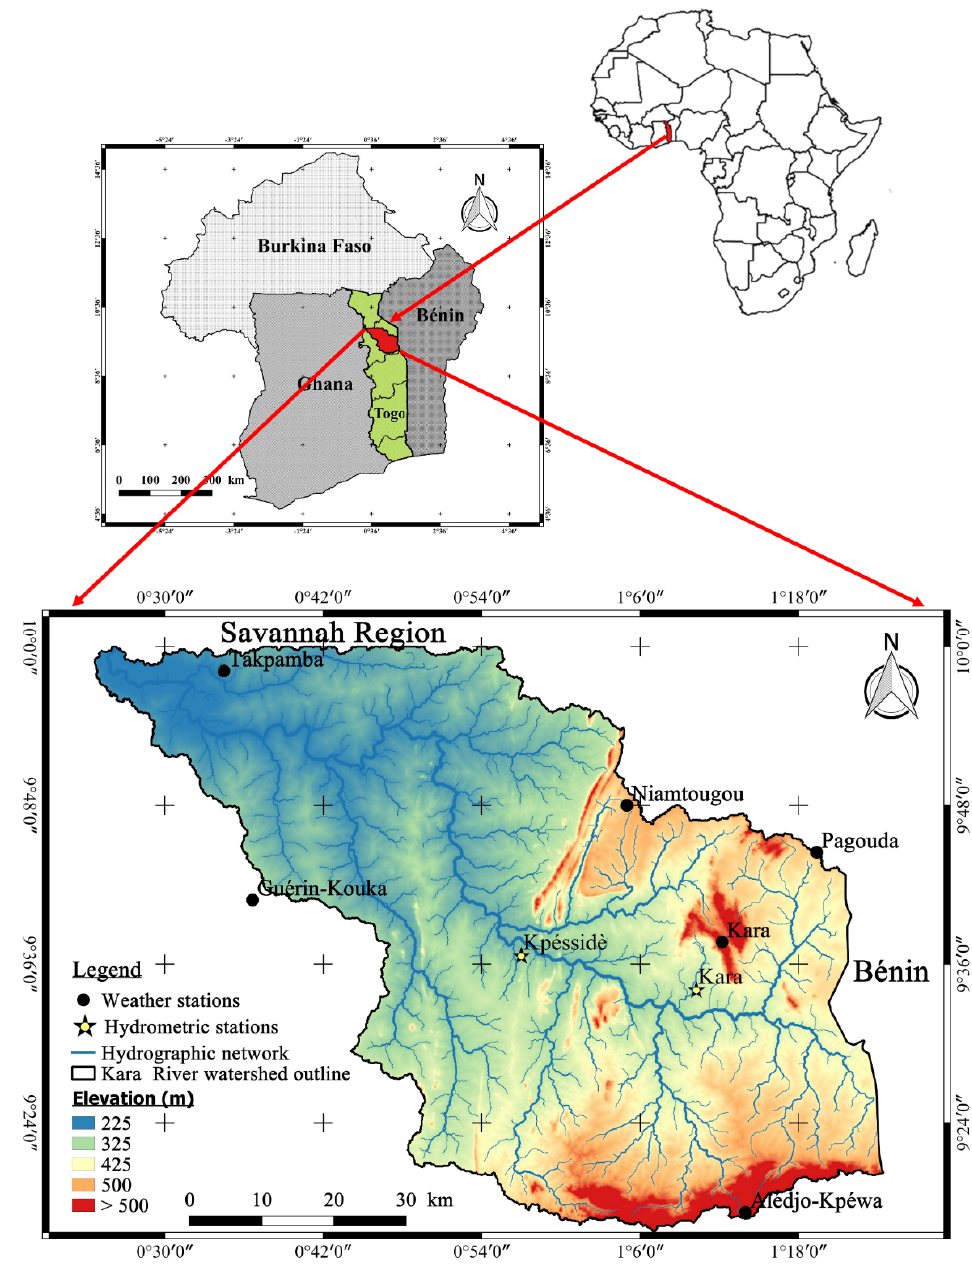
Figure 1. Geographical location, relief of the study zone and location of the different measuring stations.